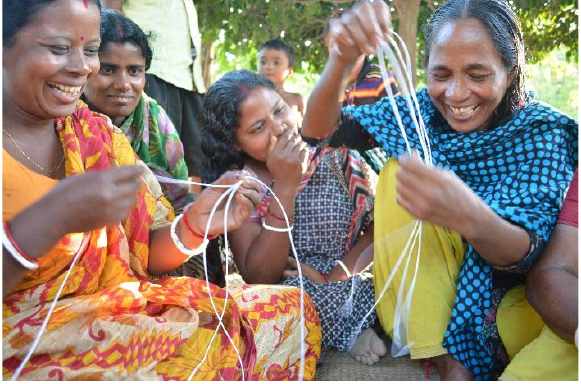
Figure 5: Women group is considering to invest their time in craft-based product making (Farzana, 2016